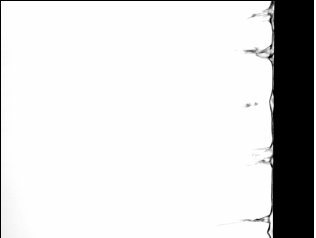
Fig. 7. An example of the liquid contours for estimation of the liquid amount on the